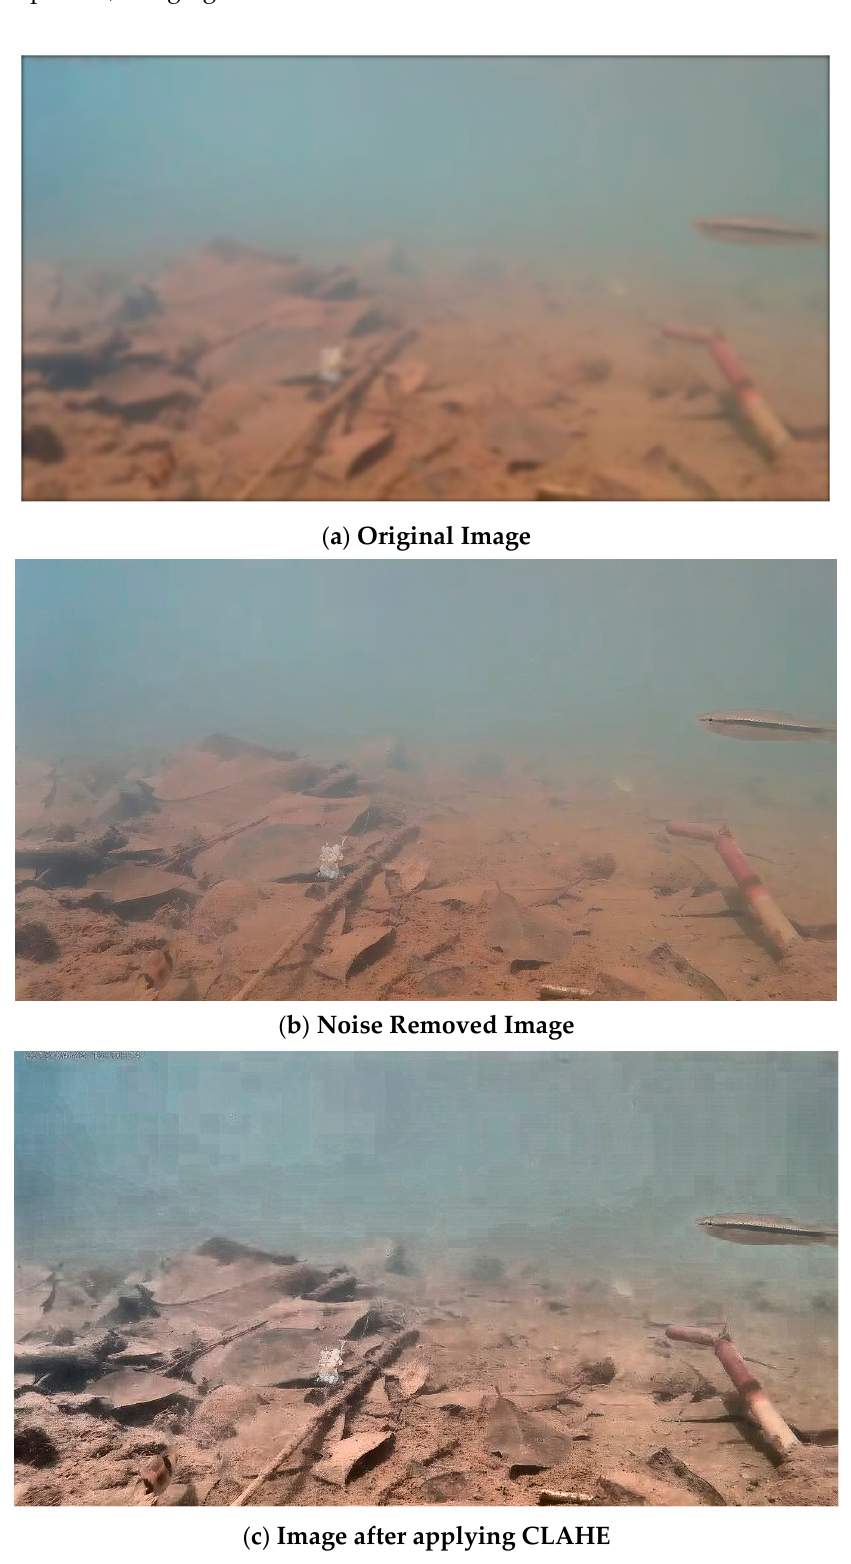
Figure 4. ( a ) Original Image (SNR = 12.92), ( b ) Reconstructed Image using the proposed method (SNR = 16.98), ( c ) Image after applying CLAHE (SNR = 20.38).